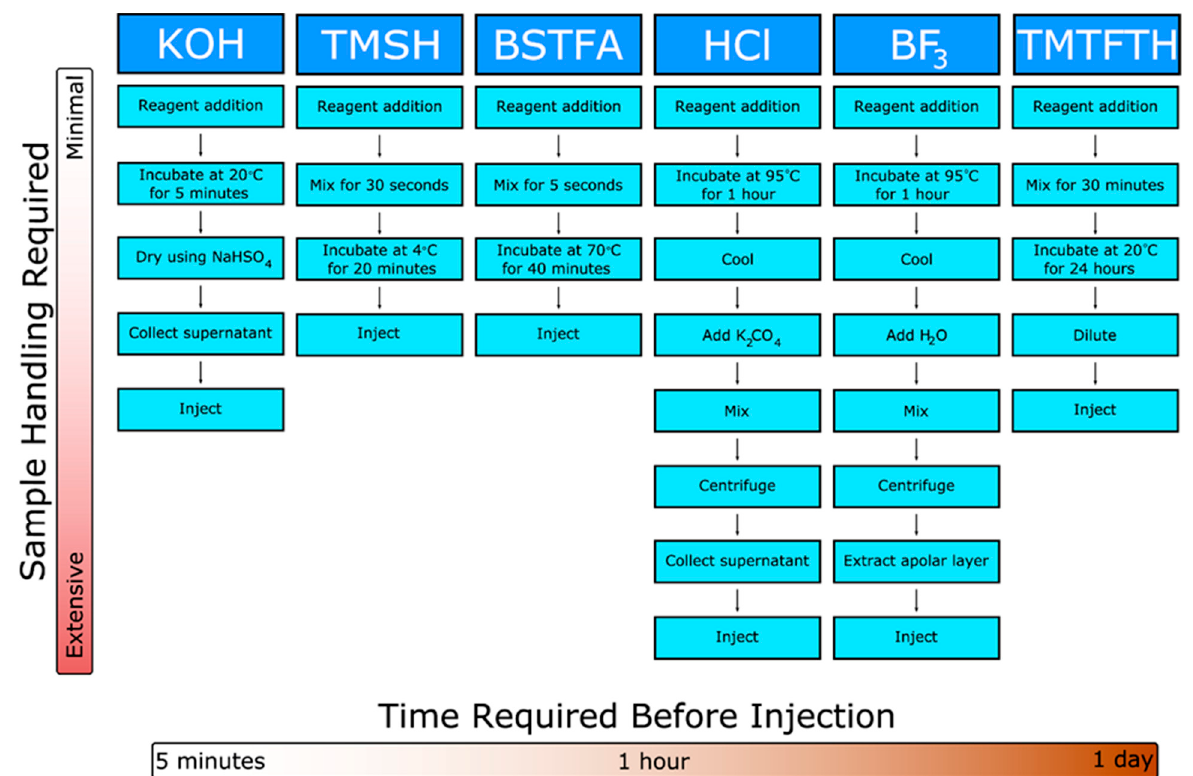
Figure 1. Time-based comparison of common fatty acid derivatization methodologies. Step-by-step workflow of common fatty acid derivatization techniques reported by various groups. Each independent step in sample preparation is illustrated, and the time required to prepare individual samples increases from left to right across the workflow. Required sample handling increases from top to bottom down each derivatization technique.